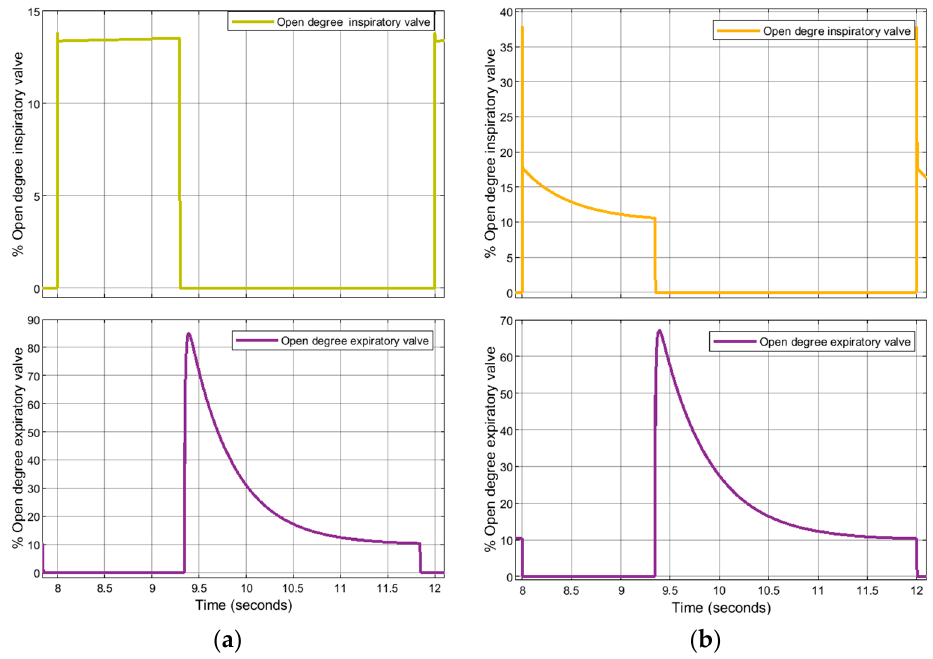
Figure 24. Case 2. Opening degree of the inspiratory and expiratory valves: ( a ) VC − CMV mode; ( b ) PC − CMV mode.